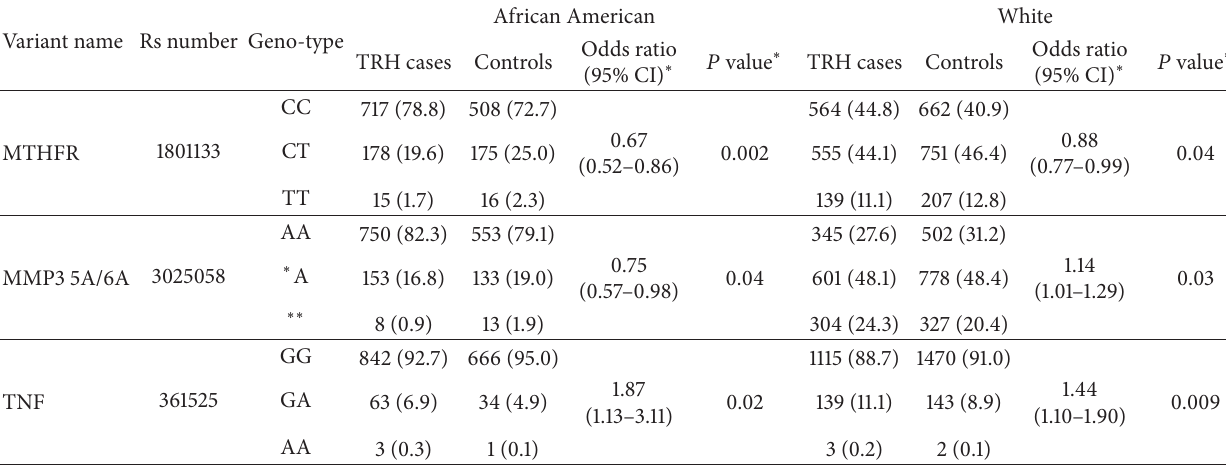
Table 5: Gene associations with treatment resistant hypertension that are suggestive for both AA and white participants. Variant name Rs number